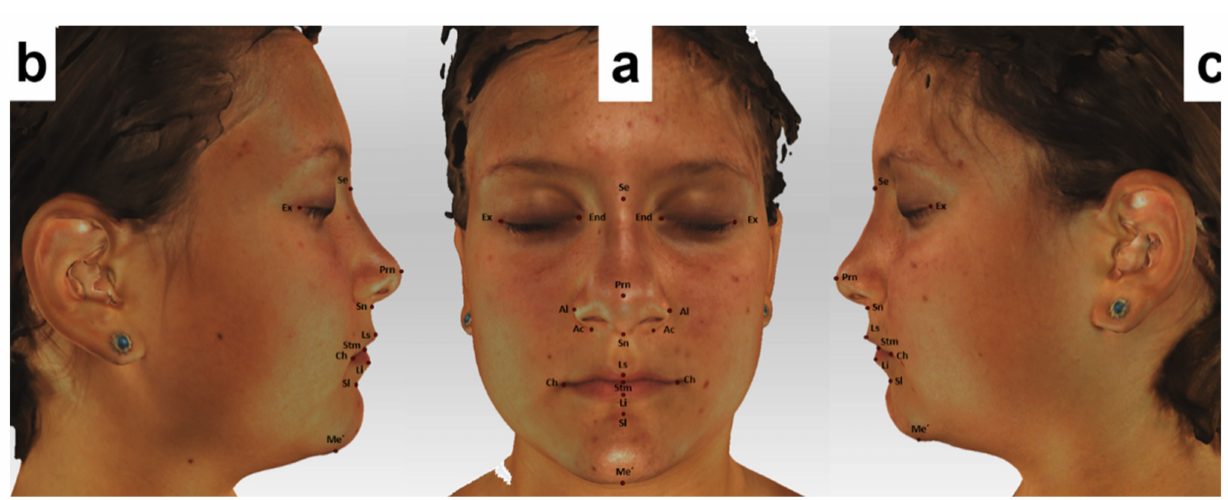
Figure 2. Landmarks used in our study located on the 3D-facial images. ( a ) Frontal view ( b ) and ( c ) lateral views. For the 3D deviation analysis, the 3D facial images were transferred into a reverse engineering software (GOM Inspect Evaluation Software, Capture 3D, Inc, Santa Ana, CA, USA) and polygon meshes were created in a stereolithography (STL) format. The hair, ears, and the below-neck region were removed. The images obtained at the T 0 time point were aligned with the images taken at T 1 using the best-fit method, as described by Dindaroglu et al. [26] (Figure